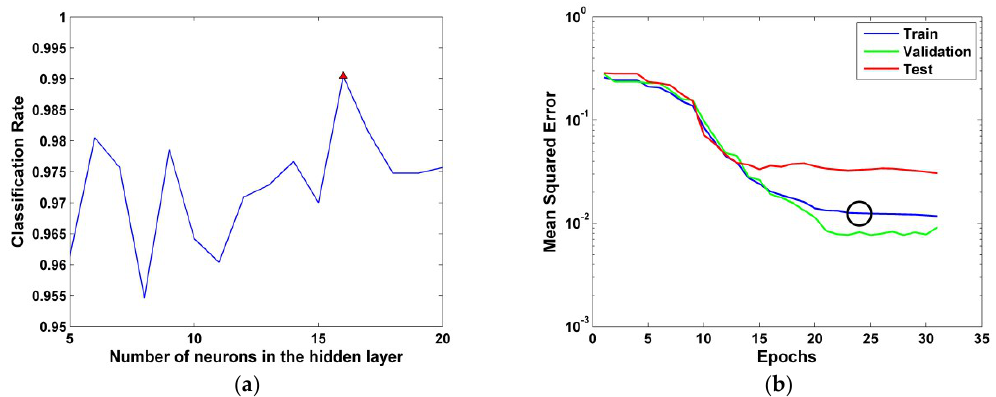
Figure 7. Training data of Back-Propagation neural network: ( a ) Classification rate for each experiment ( b ) Best Validation Performance.